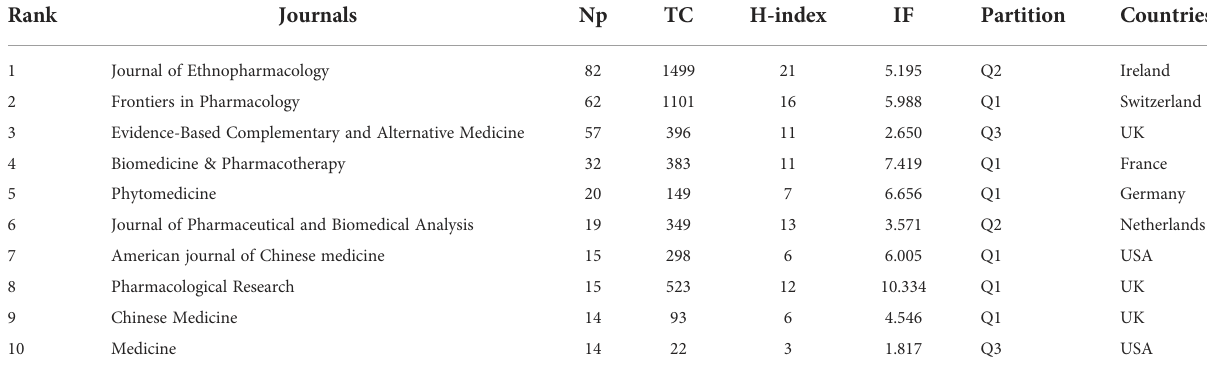
TABLE 4 The top 10 productive journals in the